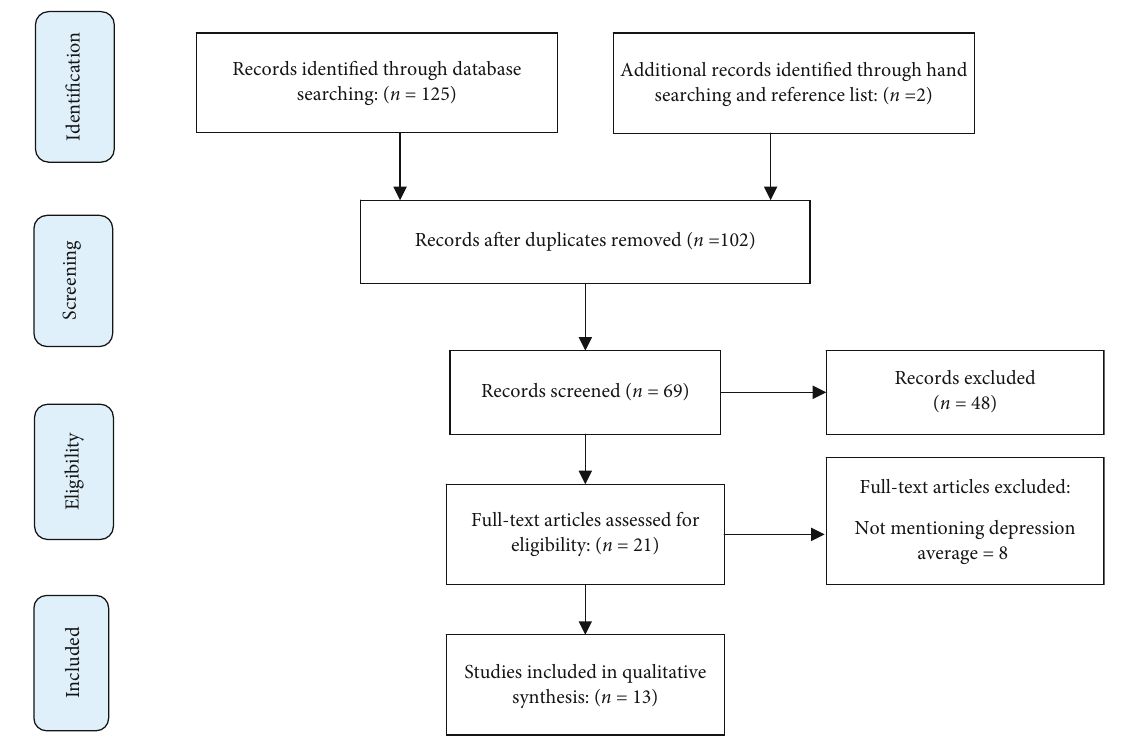
Figure 1: Flowchart of selection and review of articles based on the PRISMA statement.